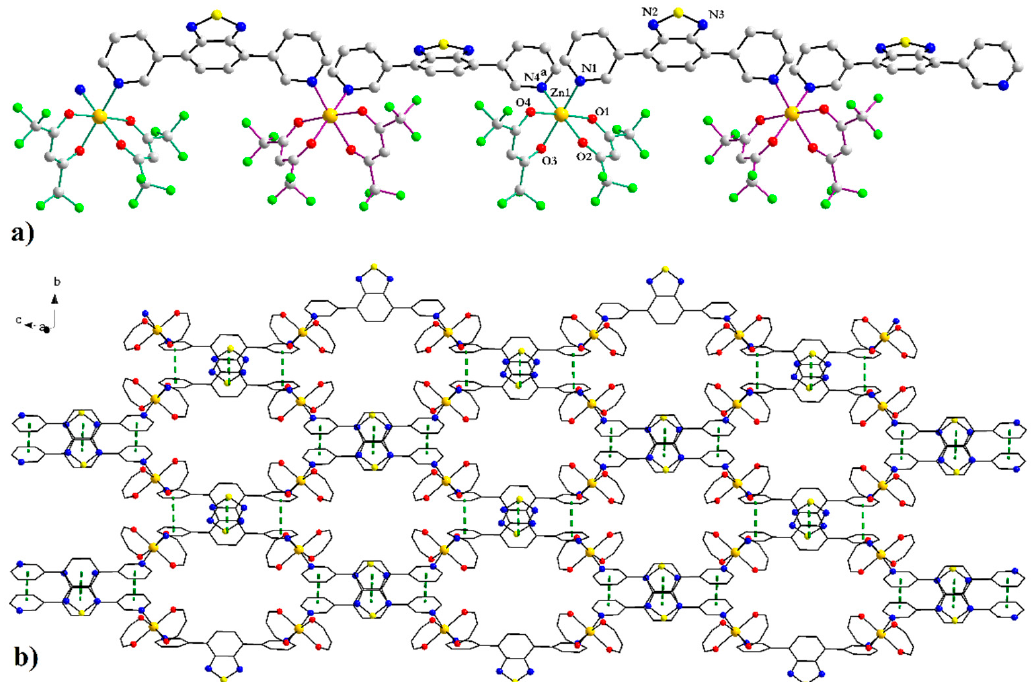
Figure 5. ( a ) Structural detail of a chain built from Zn(hfac) 2 nodes and 3-PyBTD spacers in the crystalline structure of compound 6 illustrating the opposite chirality of the alternated metal centers (green— Λ configuration, violet— ∆ configuration). Symmetry operations a = − 0.5 + x , 1.5 − y , − 0.5 + z ; ( b ) View along the a direction of the 2D layers assembled through π – π stacking between adjacent chains (CF 3 groups have been omitted for clarity).